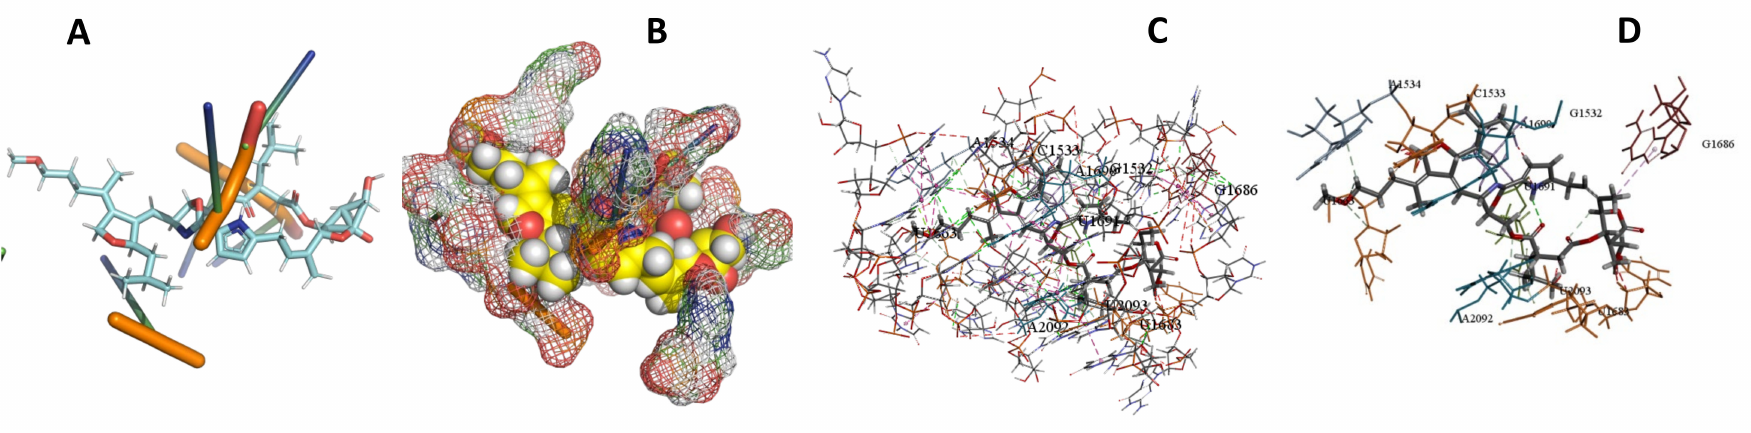
Figure 23. T. Brucei + leupyrin. ( A ): Best binding pose and nucleotides involved. ( B ): Schematic binding pocket. ( C ): shows the Nucleotides component that re involved in binding. ( D ): Shows the main bonds involved between the compound and the nucleotide